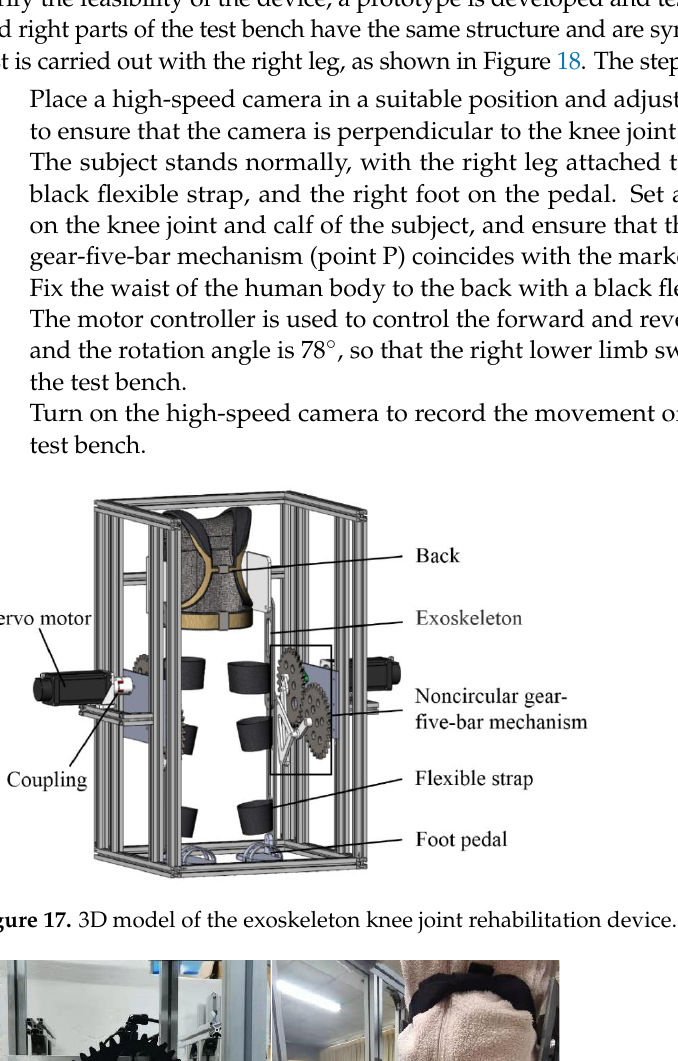
Figure 19. The movement state diagram of the lower limb when the knee joint passes through four task poses.